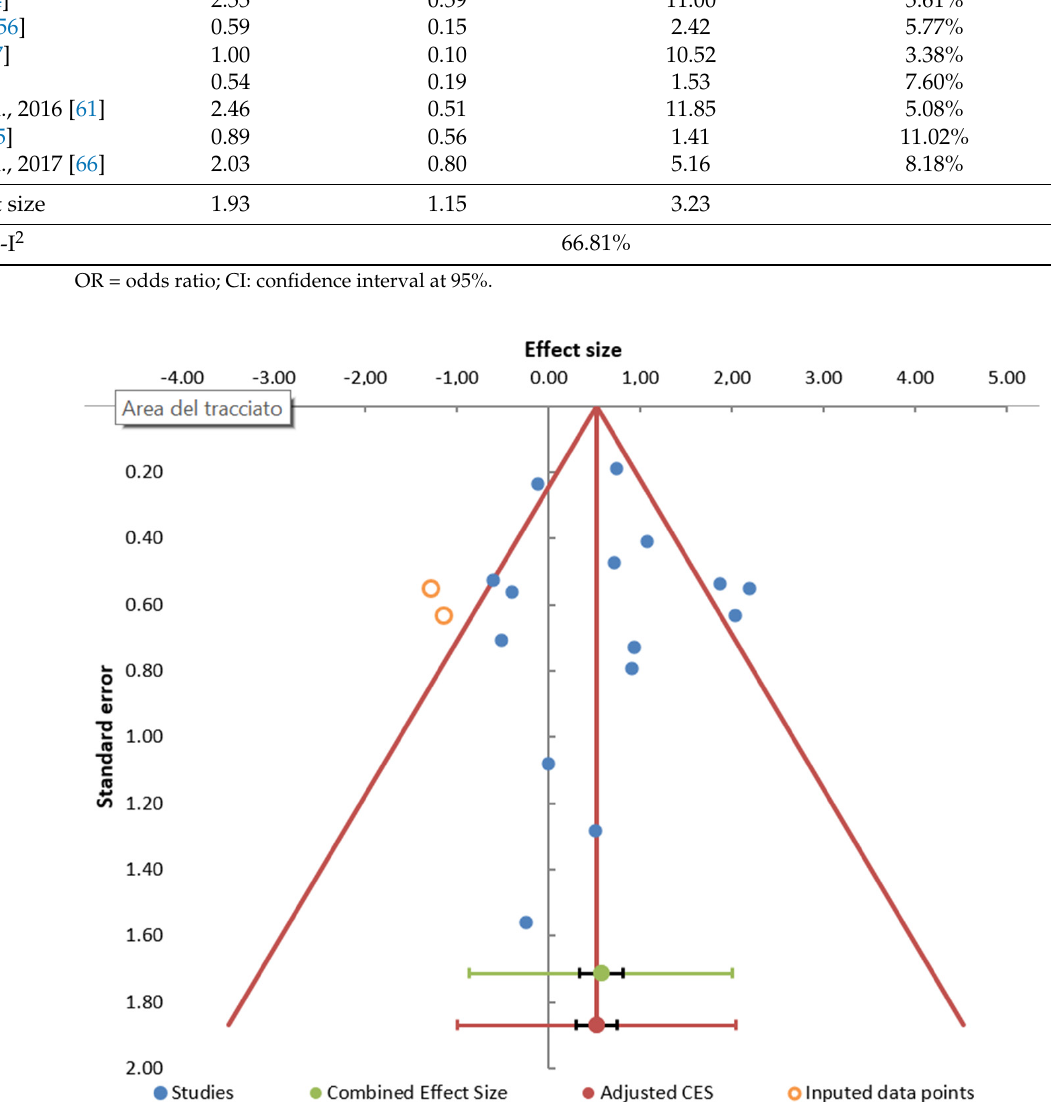
Figure 2. Forest plot of odds ratio for LD (diagnosed by antibodies) among exposed (outdoor) work- ers and other individuals not exposed (controls).